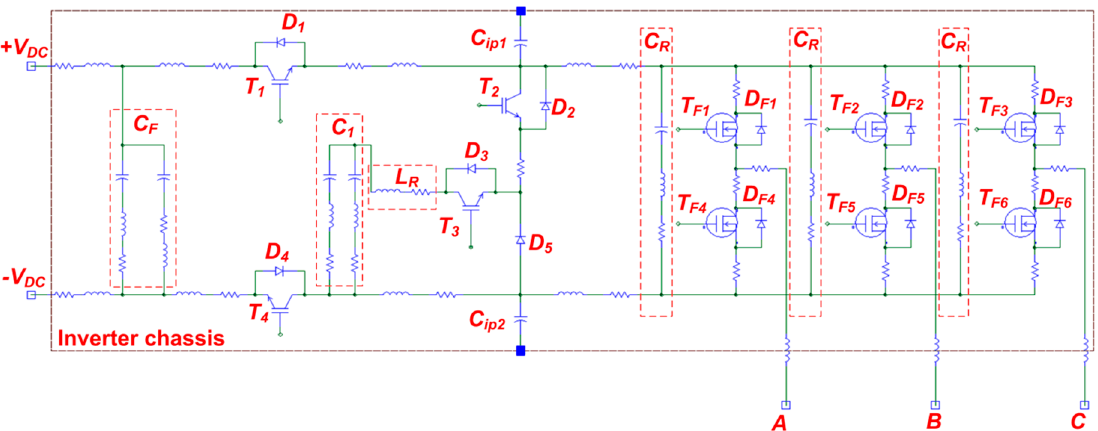
Figure 3. A simulation model of proposed PQRDCLI in SABER@Sketch editing window of SABER